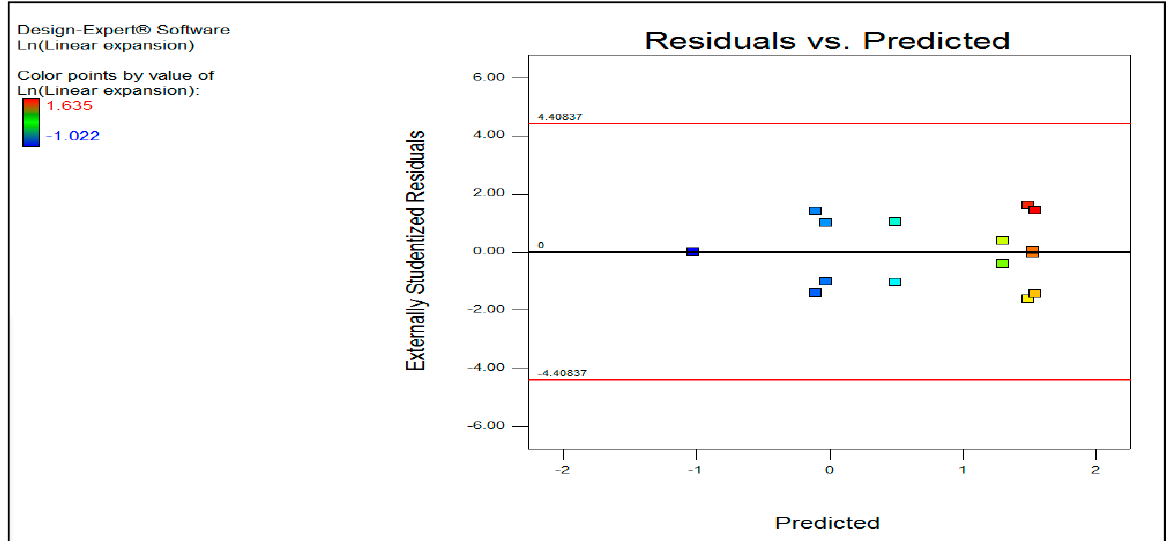
Figure 9. Residual vs. Predicted.